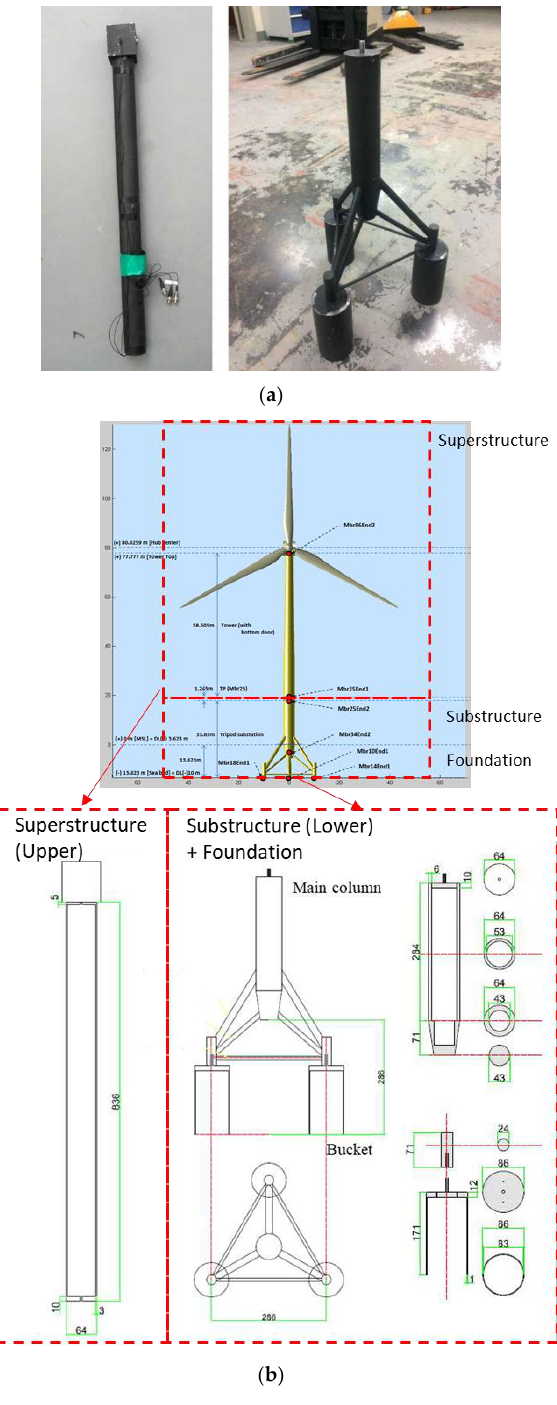
Figure 5. (a) Photograph and (b) schematic cross-section of offshore wind turbine (OWT) model. Figure 5. ( a ) Photograph and ( b ) schematic cross-section of offshore wind turbine (OWT)